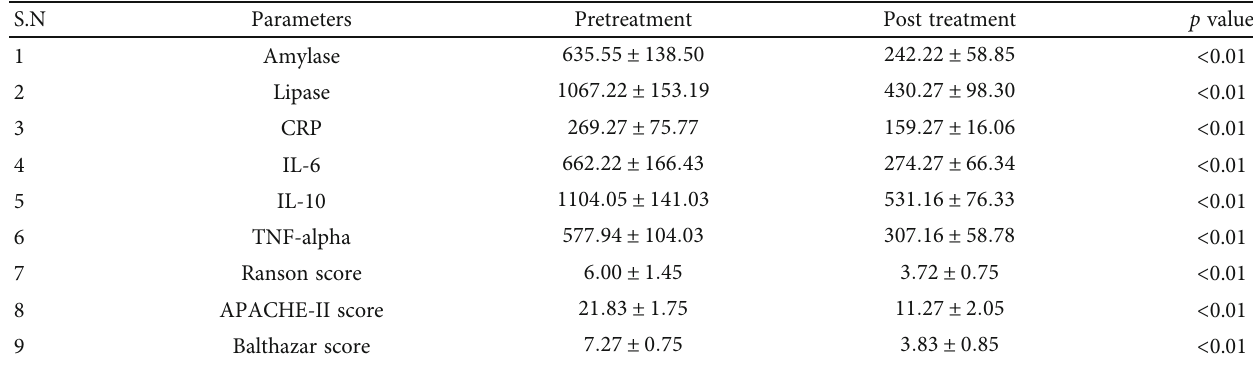
Table 4: Comparing di ff erent parameters in the CVVH treatment group pre- and post treatment.